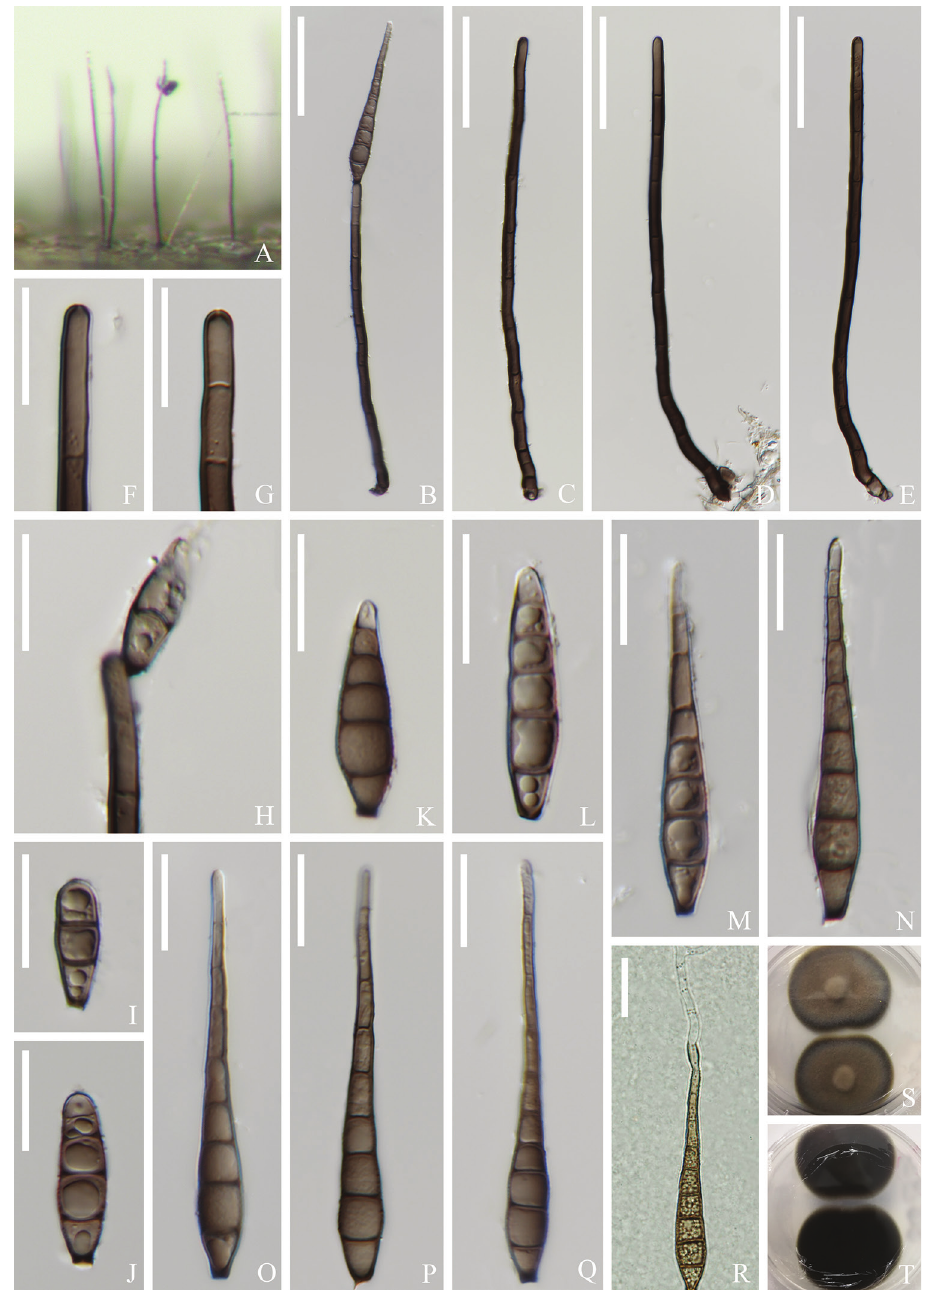
Figure 3. Distoseptispora lancangjiangensis (KUN-HKAS 112712, holotype ) A colonies on the substra- tum B conidiophore and conidium C-E conidiophores F, G conidiogenous cells H conidiogenous cell with conidium I-Q conidia R germinating conidium S, T culture on PDA. Scale bars: 50 μm ( B-E ); 20 μm ( F-R